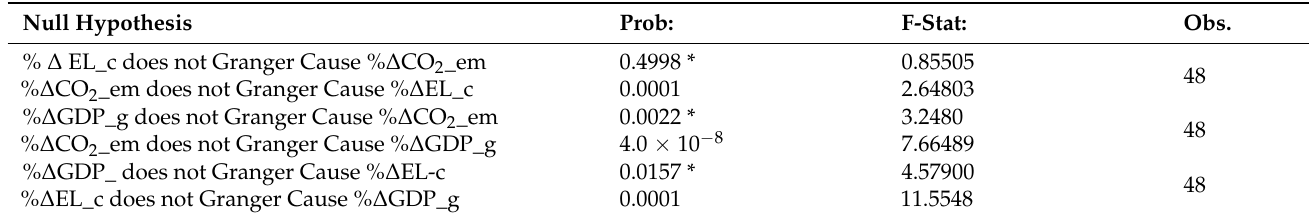
Table 7. Test of Granger Causality.